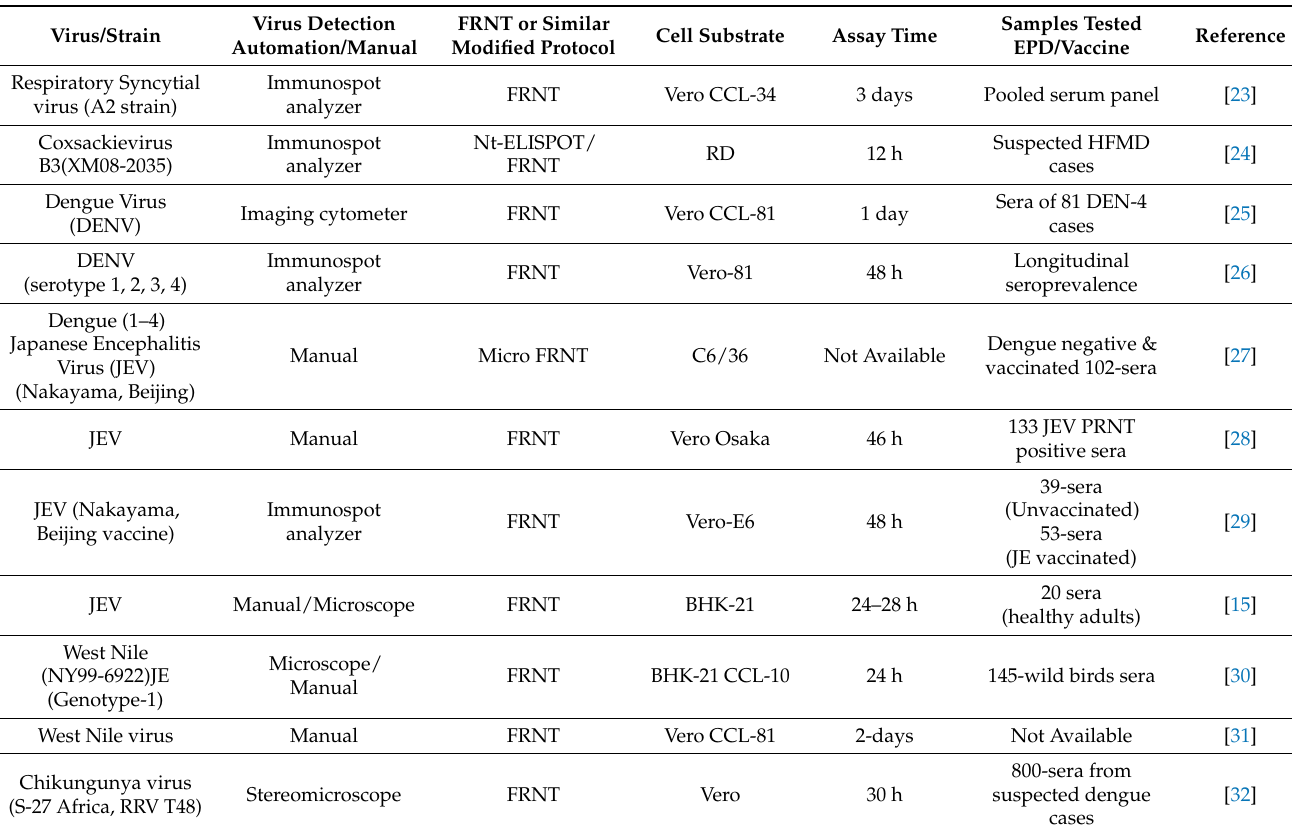
Table 1. Published immuno-staining-based neutralization tests for various viruses important for public